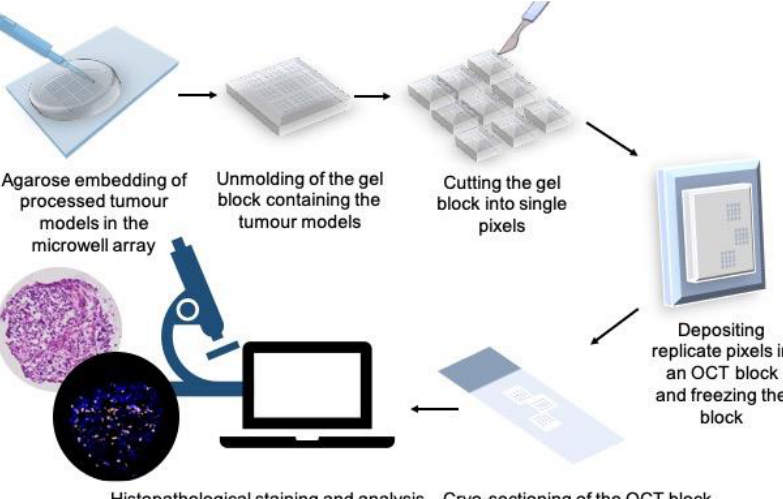
Figure 5. Protocol developed to remove the tumour models from microwells while preserving their address for further histopathology analyses. Tumour models are first embedded in agarose and the gel is removed from the microwell array. Microwell groups exposed to different fluidic pixels are separated, and tumour models that have been subjected to the same treatment condition are grouped in an OCT block. OCT blocks are sectioned in 5 µm sections to visualize the tissue core and for further immunostaining. After demonstrating that the PCD platform is capable of forming crosstalk-free flu- idic pixels over various tumour models, we sought to examine the ability of the